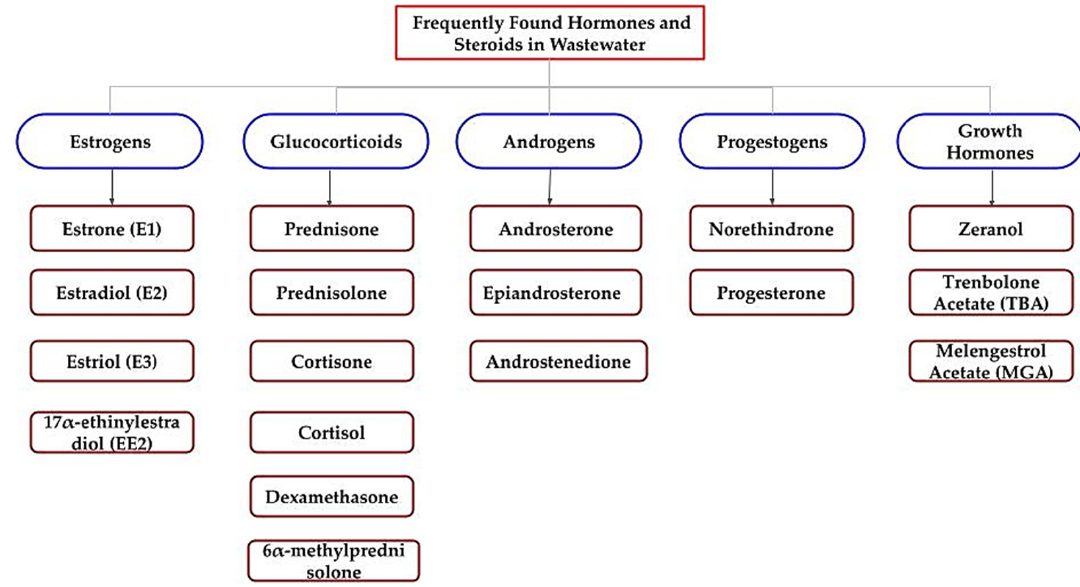
Figure 2. Scheme of the potential endocrine disruption steroids and hormones.